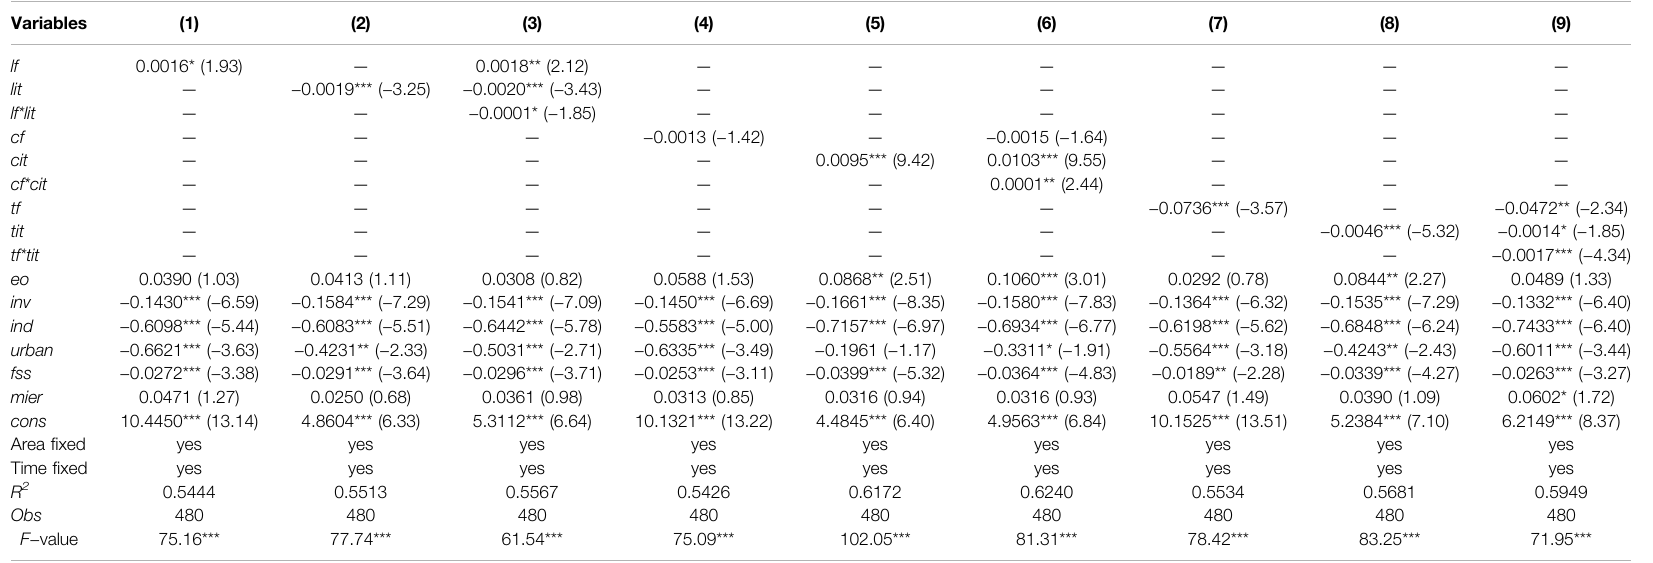
TABLE 3 | Results of baseline